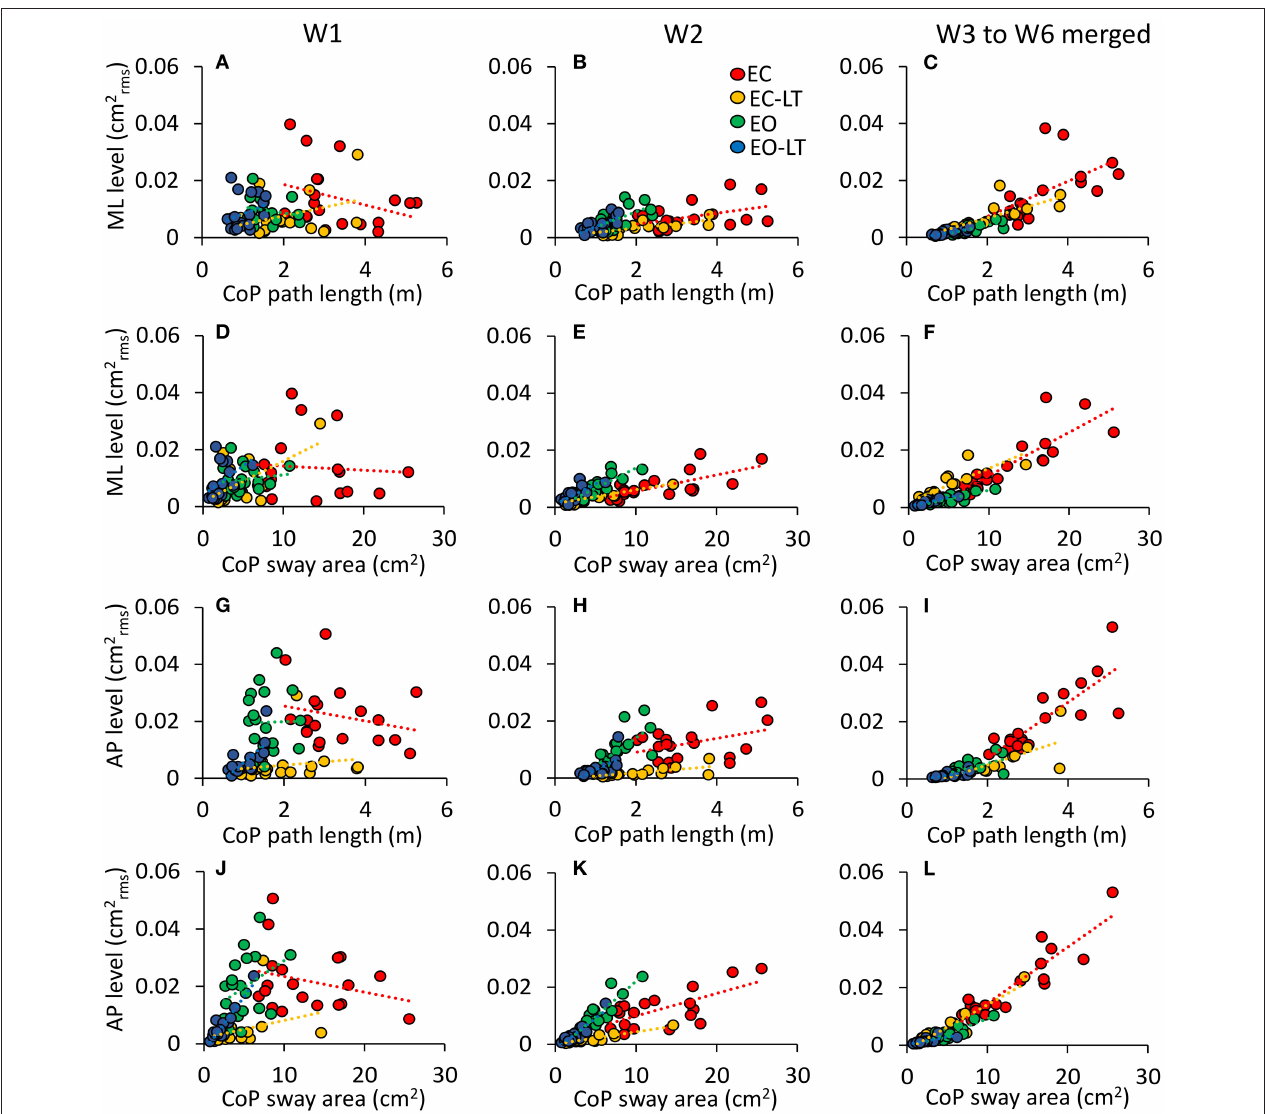
FIGURE 11 | Not all the frequency windows match the geometric sway measures. The contribution of the ML (A–F) and AP (G–L) sway frequencies to the geometric sway measures is limited to high frequency windows (EC, red; EC-LT, yellow; EO, green; EO-LT, blue). The columns refer to W1 (A,D,G,J) , W2 (B,E,H,K) , and from W3–W6 (C,F,I,L) . Each symbol refers to one subject. (A–C,G–I) The spectrum amplitudes vs. the CoP path length, and (D–F,J–L) the spectrum amplitudes vs. the sway area. For both sway area and path length, the slope of the regression lines increases with frequency under all sensory conditions but only for W2 onwards.